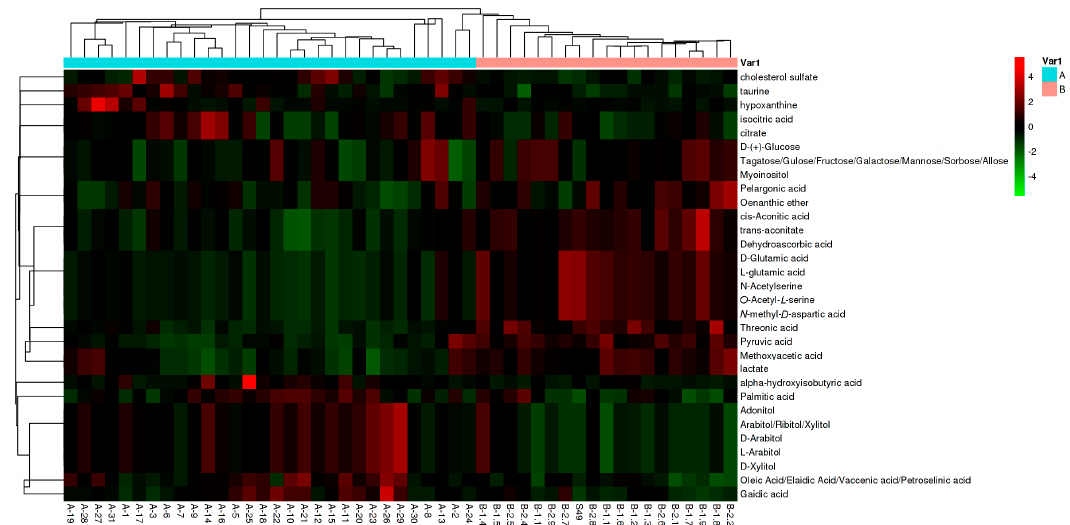
Figure 4. Hierarchical cluster analysis heat map of differential serum metabolites between NOA and healthy controls. Red indicates up-regulation, and green indicates down-regulation. The columns and rows represent experimental serum samples and metabolites, respectively.